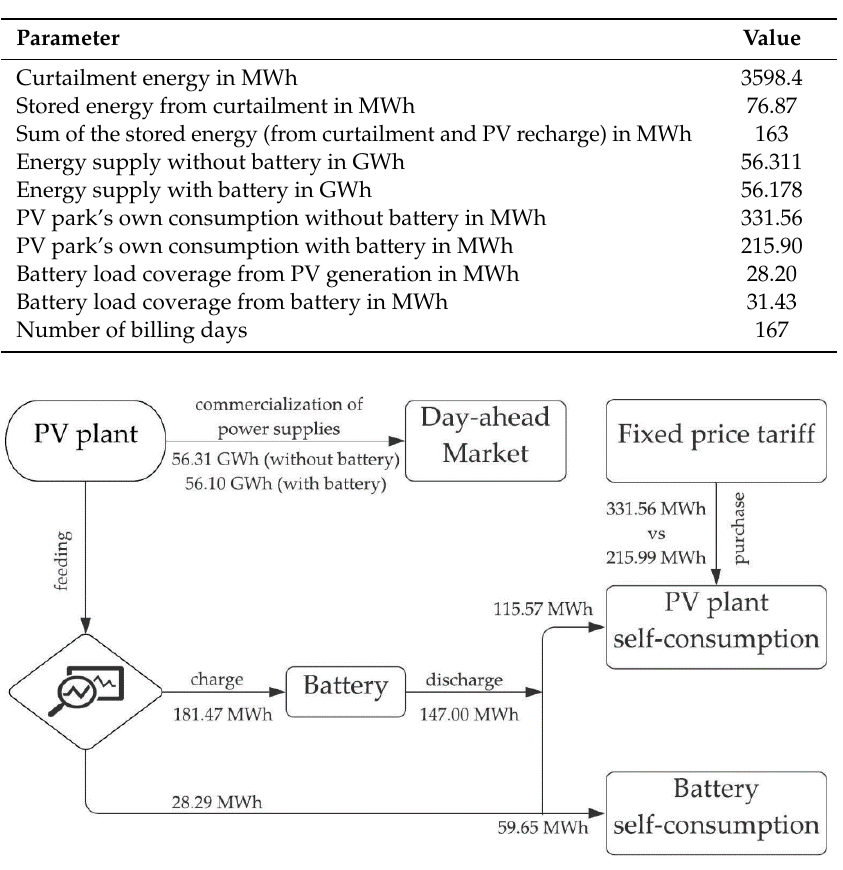
Table 4. Results for the adopted model. Parameter